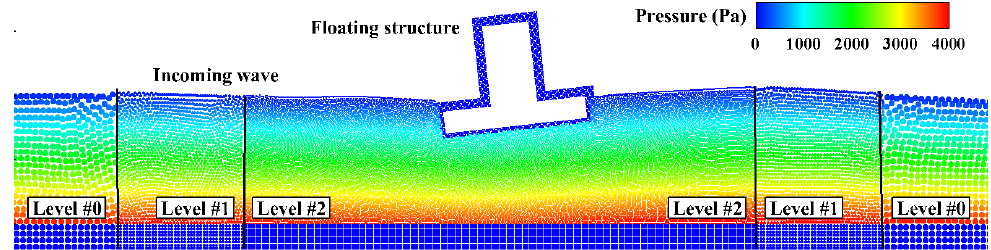
Figure 22. Wave–structure interactions simulated via a single-phase SPH model with APR